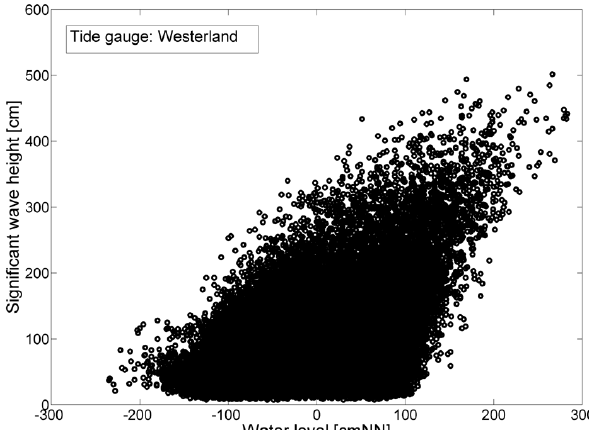
Fig. 2. Observed water levels (from tide gauge) and significant wave heights (from wave measurement station) in Westerland on the west side of Sylt